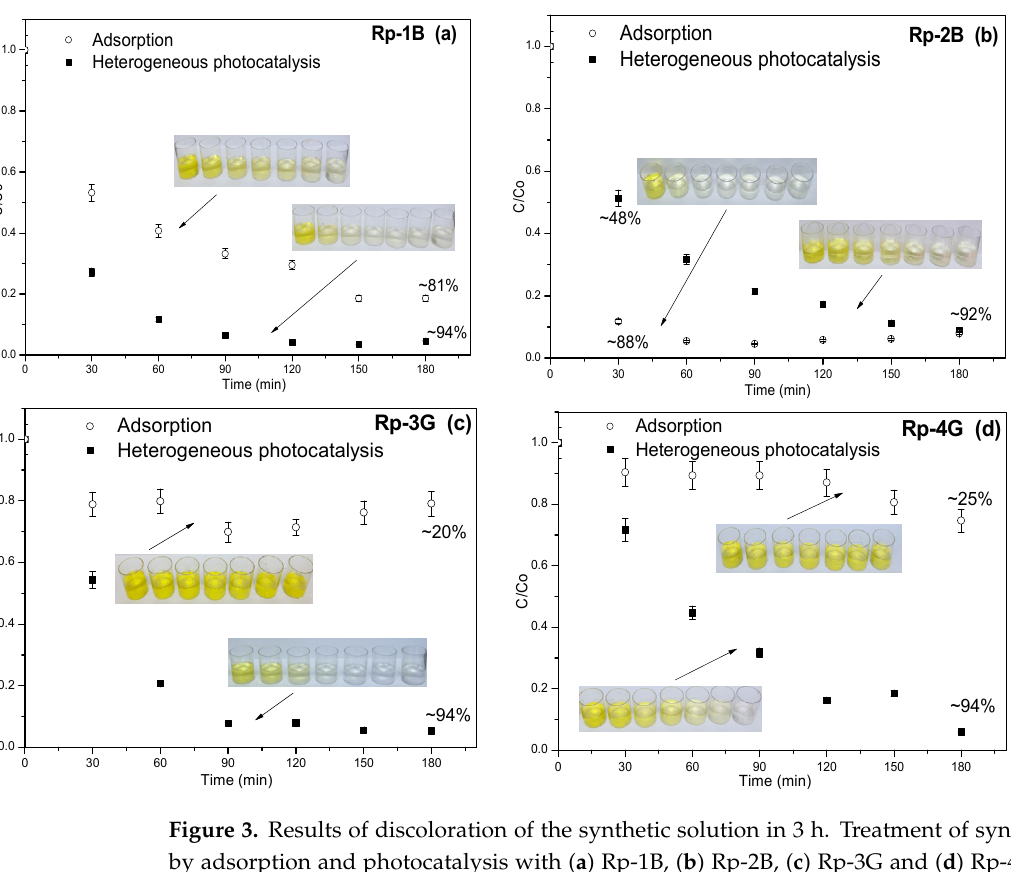
Figure 3. Results of discoloration of the synthetic solution in 3 h. Treatment of synthetic effluent by adsorption and photocatalysis with ( a ) Rp-1B, ( b ) Rp-2B, ( c ) Rp-3G and ( d ) Rp-4G. Error bars represent the standard deviation of measurements for the tests.